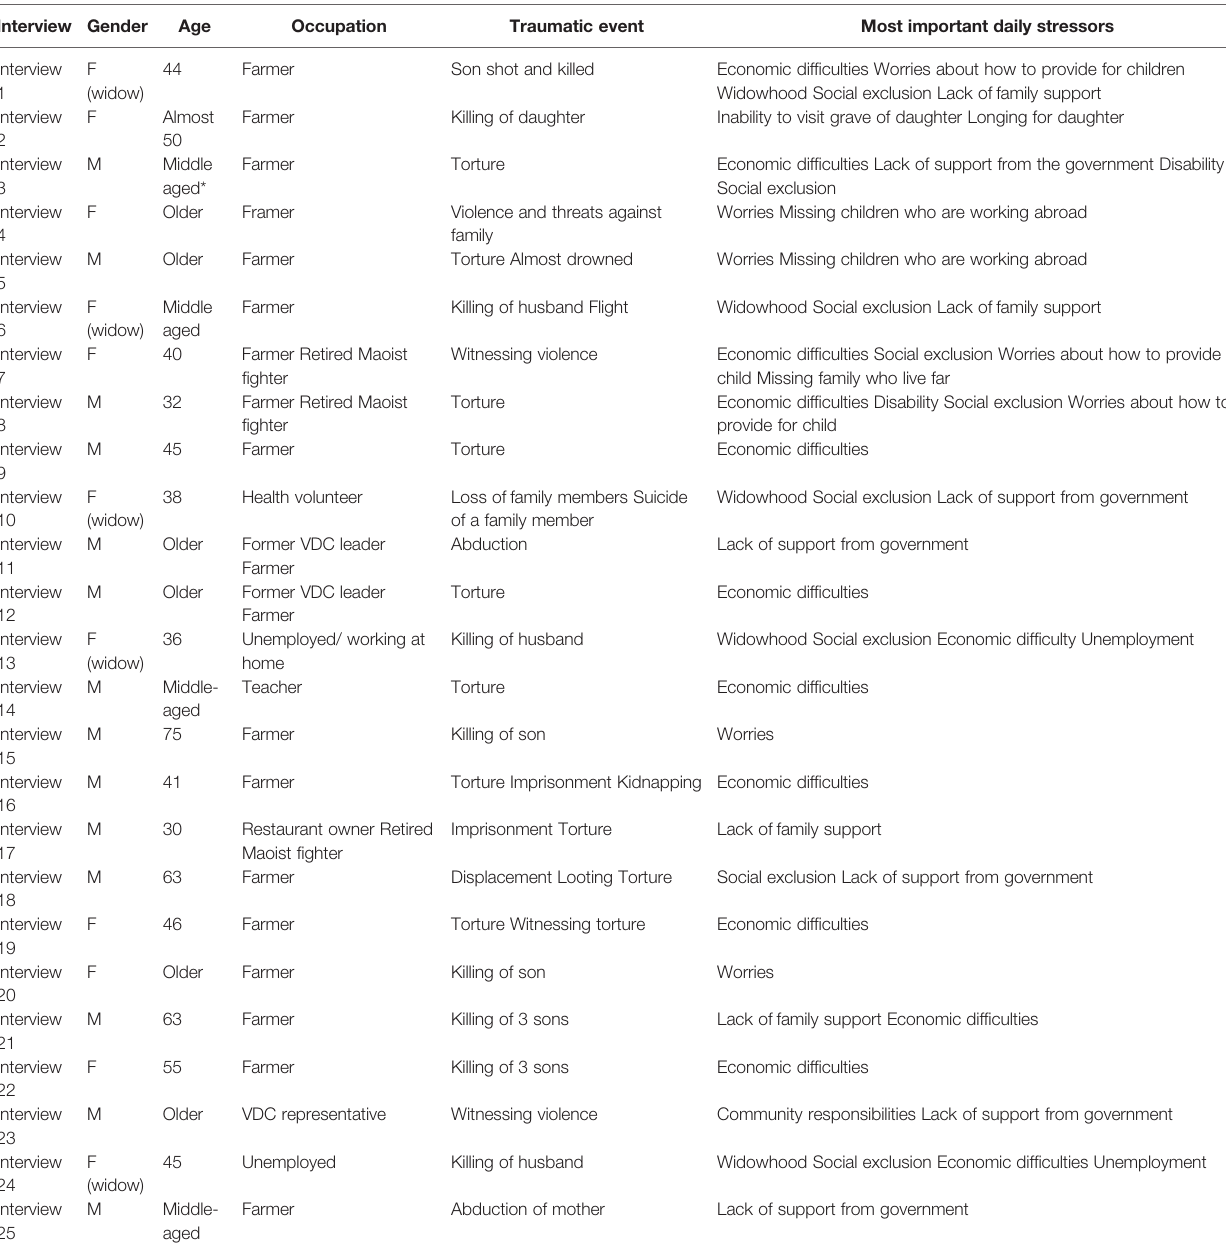
TABLE 1 | Study participants including traumatic experiences and most important daily